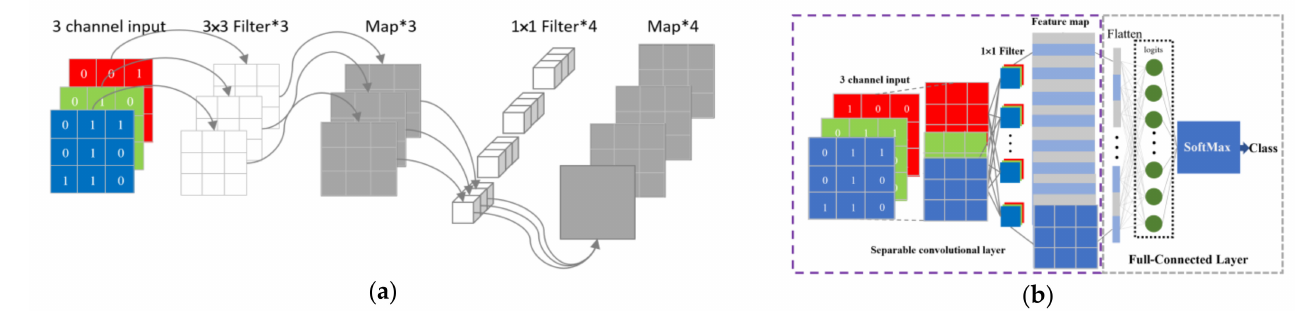
Figure 6. ( a ) The separable convolutions. ( b ) The separable convolutional neural network.